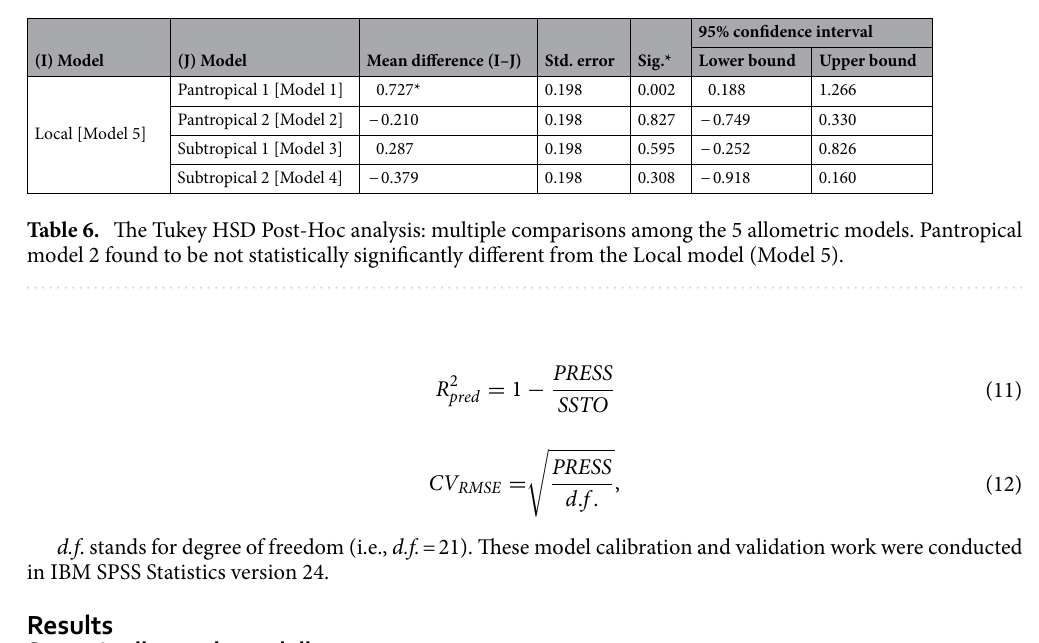
Stage 2: LiDAR AGB model derivation. The models in various forms (i.e., Model I/II/III in Table 4)